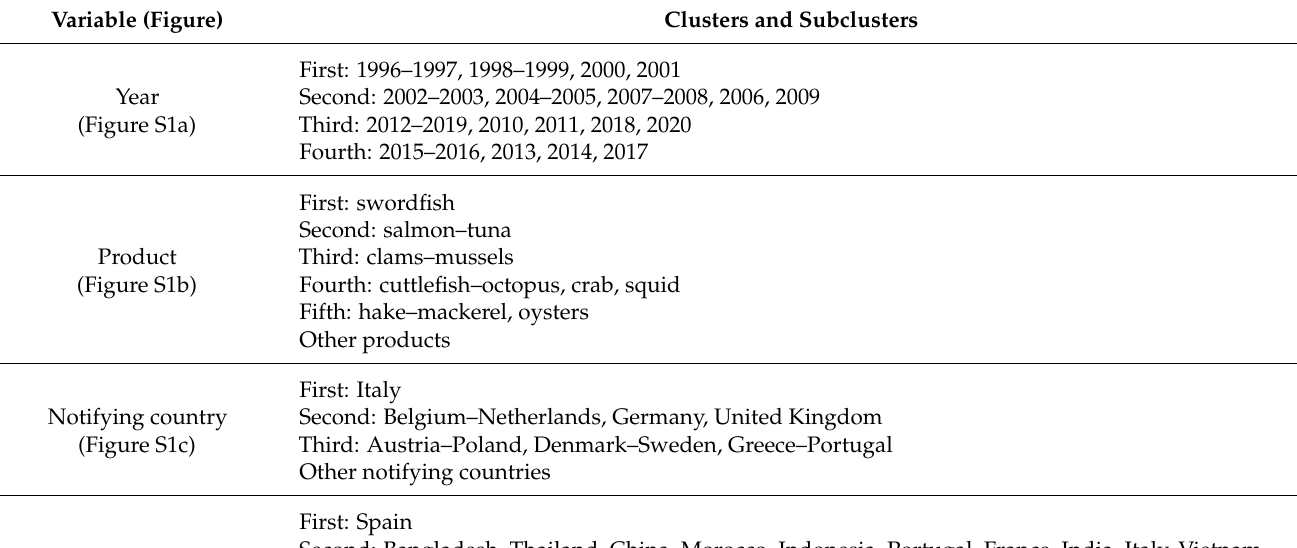
Table 4. Results of joining cluster analysis related to notifications on seafood in the RASFF